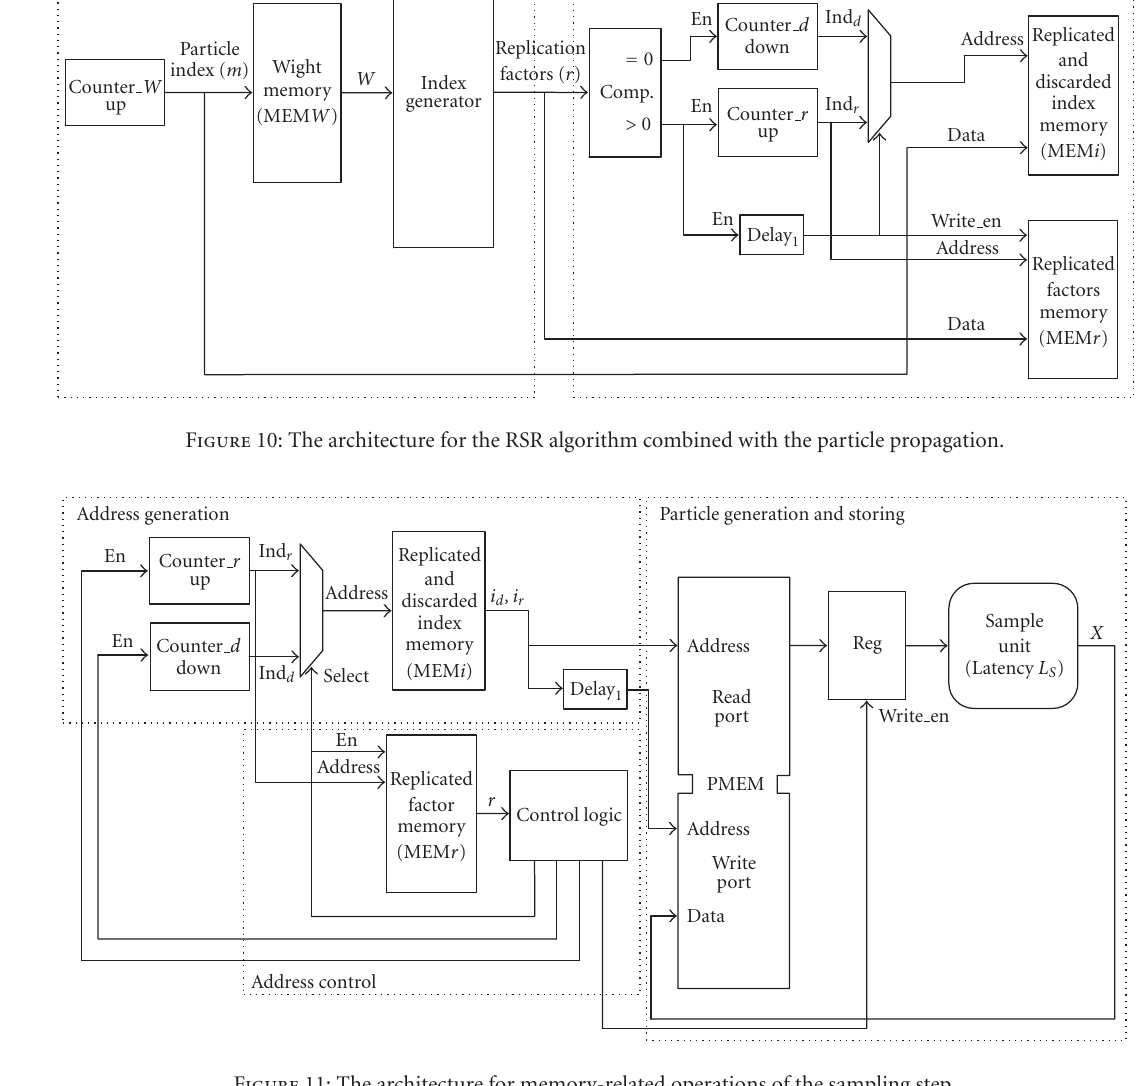
Figure 11: The architecture for memory-related operations of the sampling step.